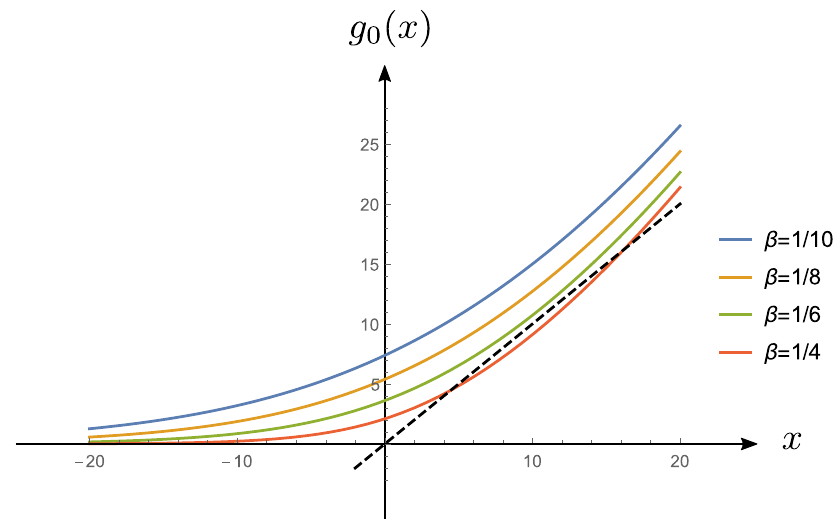
( x ) for fixed a = 1, µ = 1 and different values of β . The dashed Figure 8: Plot of g 0 line is the plot for the function f ( x ) = x . We see that there’s a lower bound of β below which the system breaks down. This implies that there’s a upper bound on the temperature, which is the Hagedorn